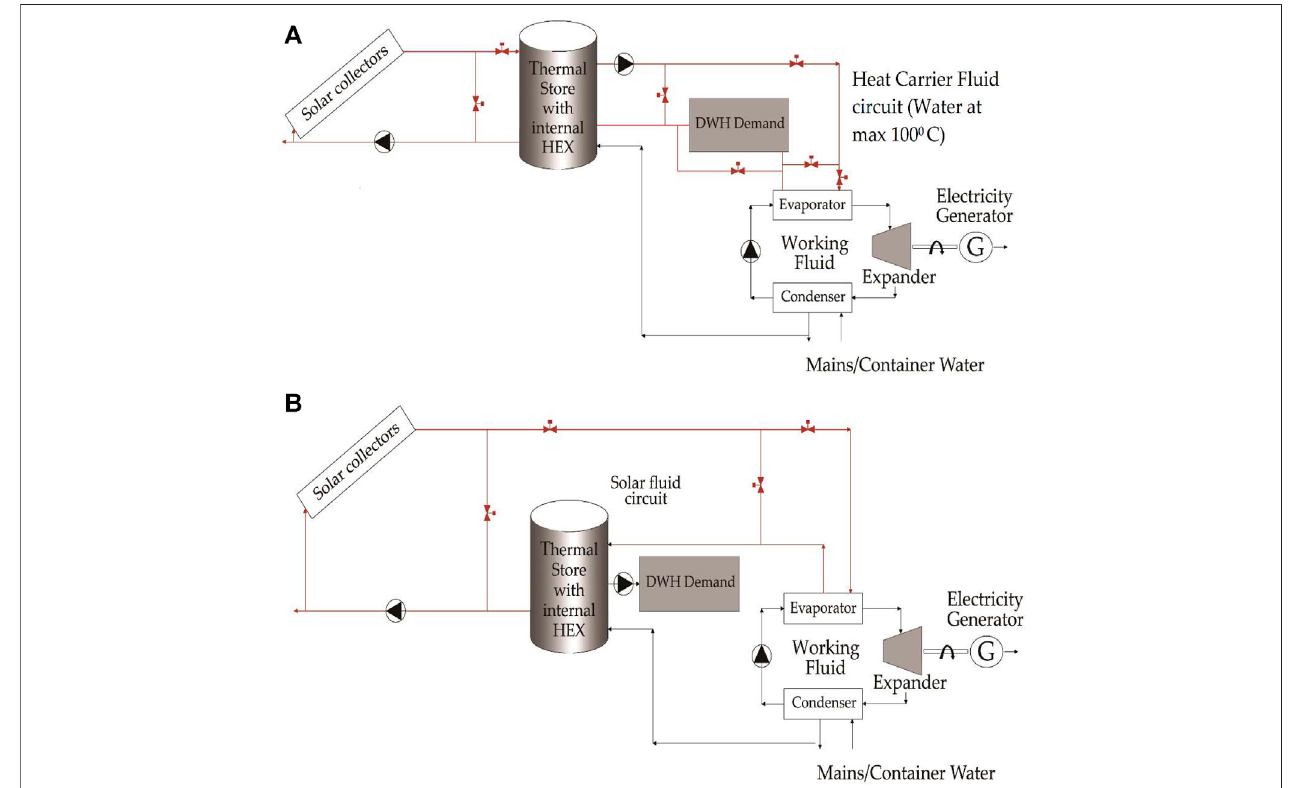
FIGURE 8 | Schematic of a CHP system using ORC and thermal storage (Freeman et al., 2017).